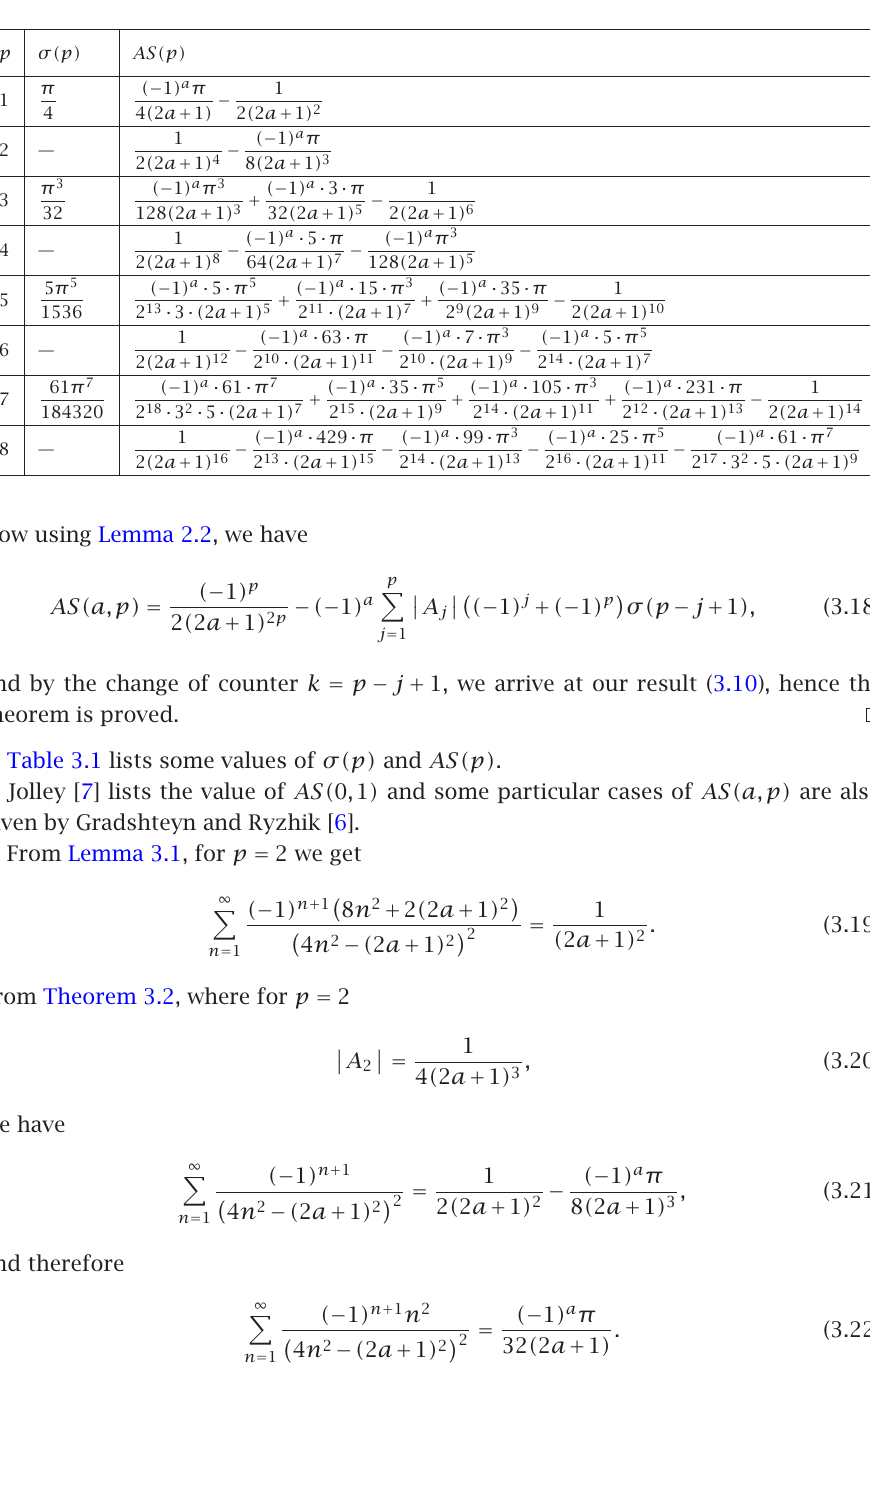
Table 3.1 . Some values of σ(p) and AS(p)